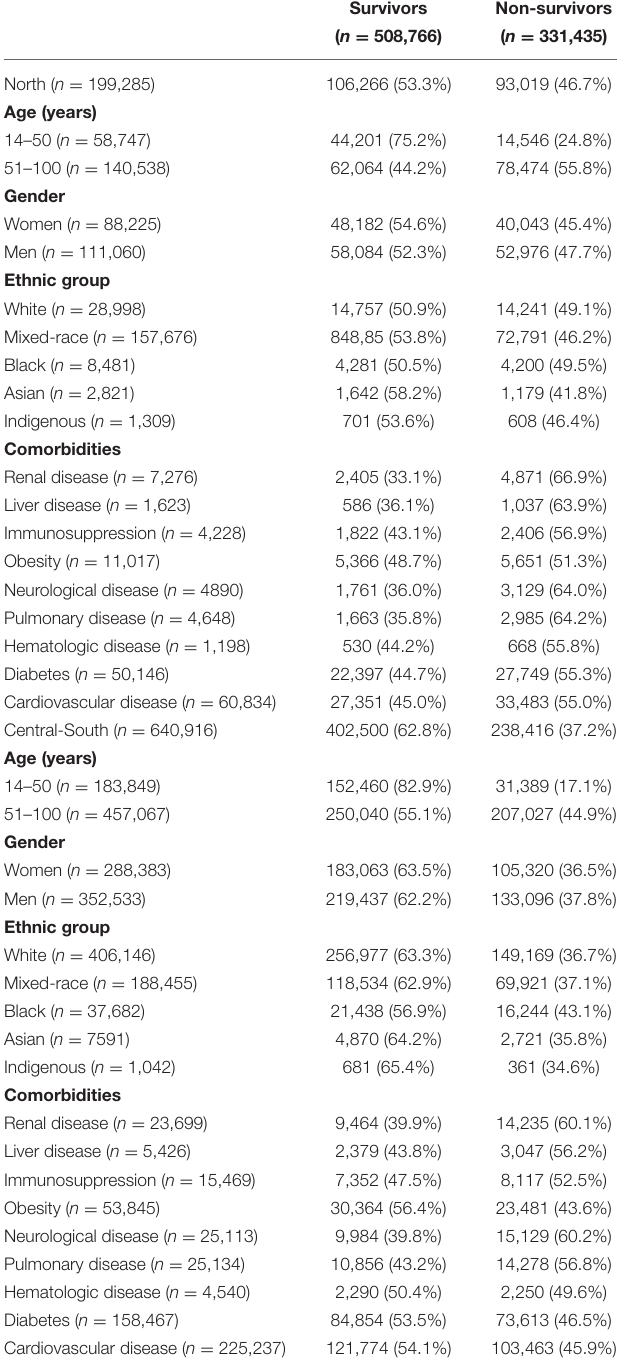
TABLE 1 | Demographic characteristics and comorbidities among COVID-19 survivors and